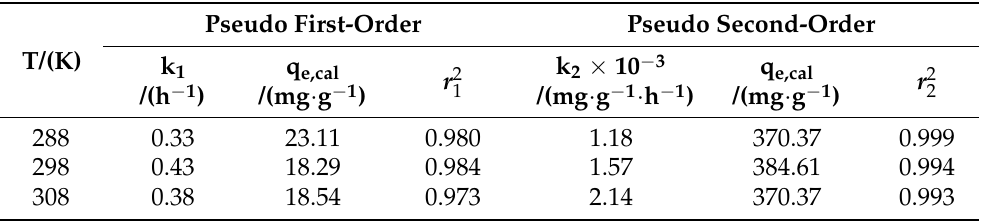
Table 2. Adsorption kinetic model rate constants for AQ2S adsorption on rGO/Fe 3 O 4 at vari- ous